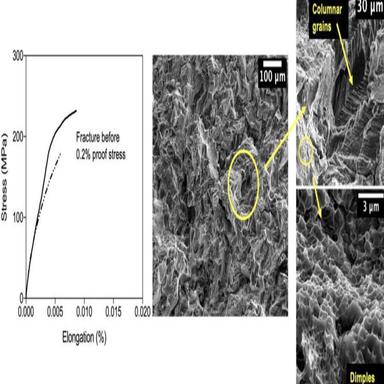
Representative tensile data showing the failure before 0.2% proof stress of LPBF prepared Al-10Zn-2Mg (represented by continuous lines) and Al-14Zn-3Mg (represented by dotted lines). The representative fracture morphology shows the presence of cleavages, dimples and columnar grains that were exposed to the fracture surface denoting a mixed mode of brittle, ductile and intergranular fracture.